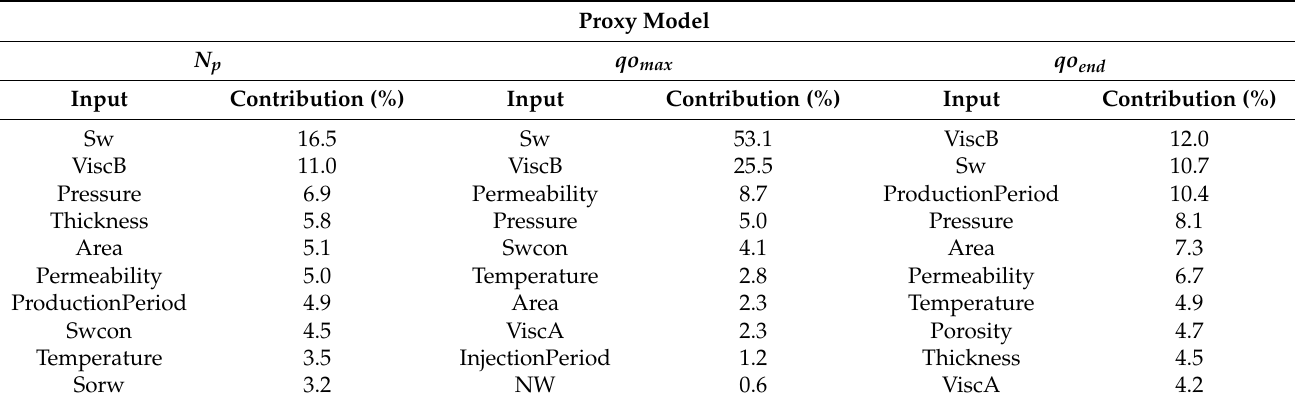
Table 2. Input parameters with the highest contribution towards the output for each proxy model of reservoir production performance based on Sobol